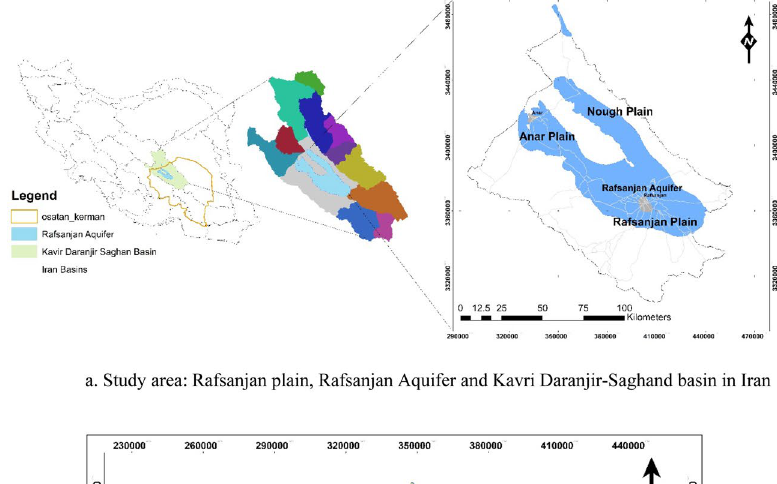
Fig. 1 a Study area: Rafsanjan plain, Rafsanjan Aquifer and Kavir Daranjir–Saghand basin in Iran. b Topographic changes in Rafsanjan plain area. c